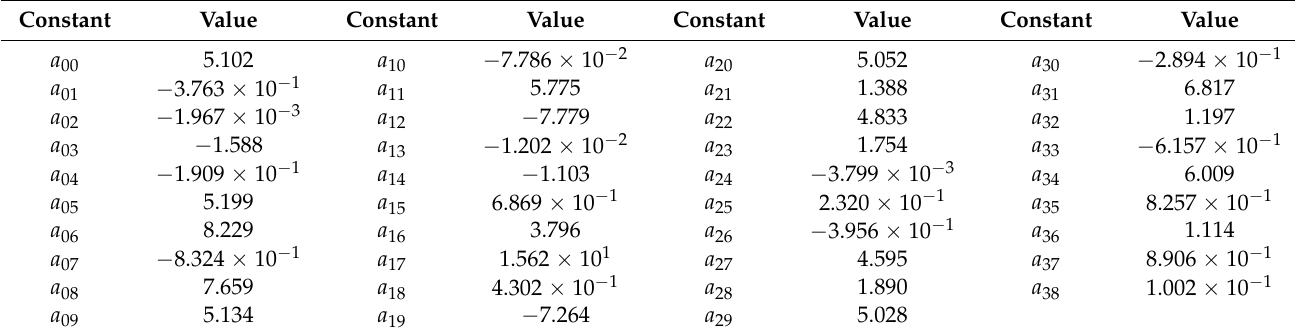
Table A1. Rounded values of the constant for Equation